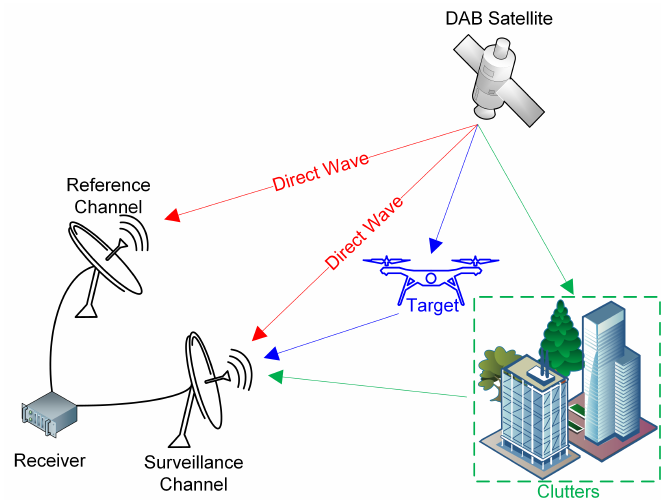
Figure 1. System diagram of PBR based on DAB